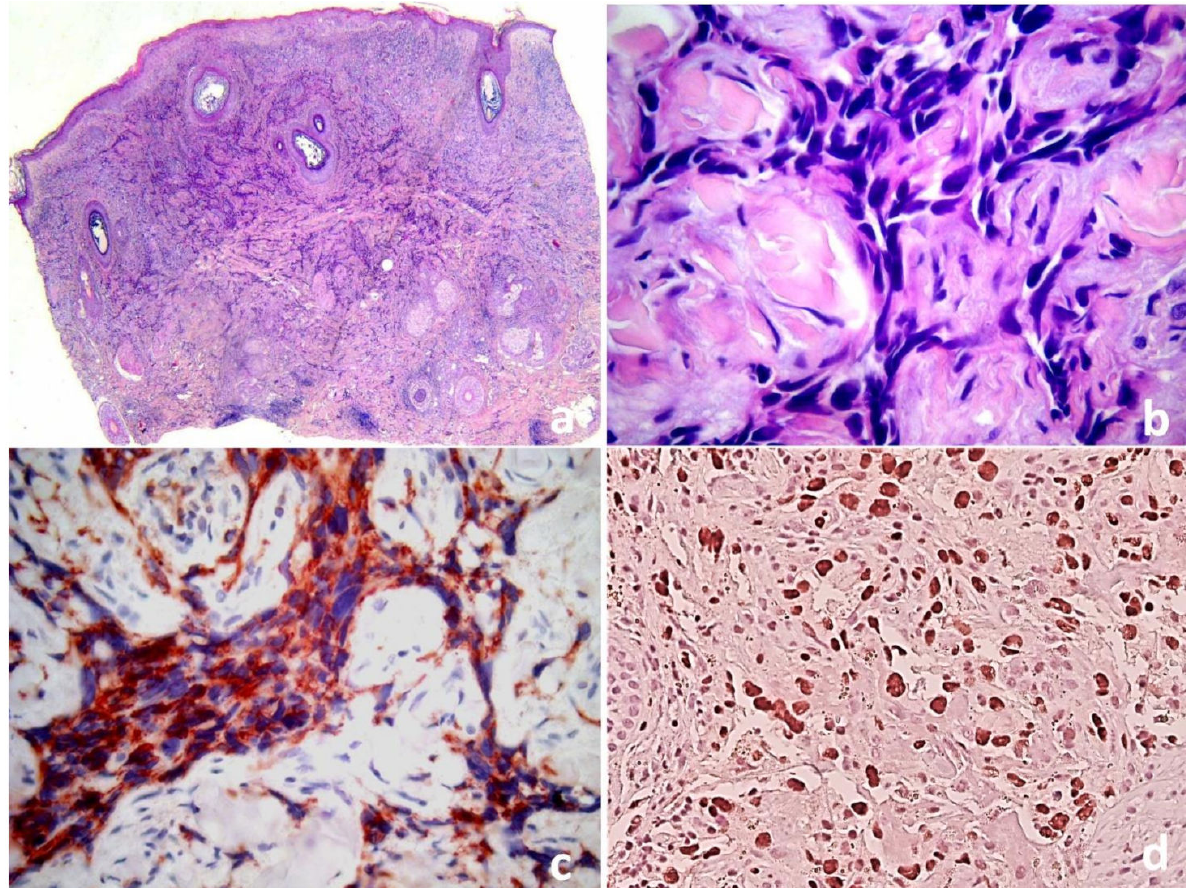
Figure 2. ( a ) Cutaneous angiosarcoma: proliferation of irregular vessels dissecting through the dermis. ( b ) Higher magnification demonstrates slit-like irregular vessels lined by atypical endothelial cells.The endothelial differentiation of malignant cells is demonstrated by CD31 cytoplasmic ( c ) and ERG nuclear expression ( d ) (IHC, 10 ×